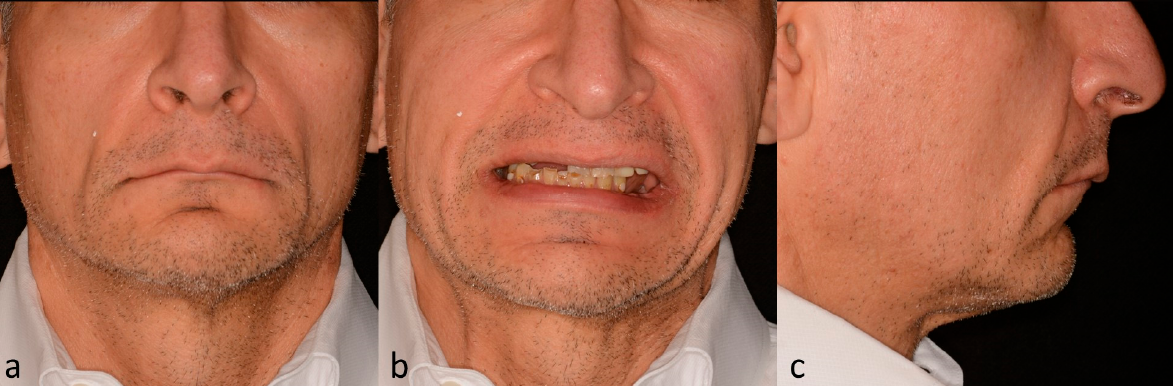
Figure 1. Initial situation. ( a ) Closed mouth, ( b ) Smile frontal view. ( c ) Lateral view with a closed mouth. The intraoral examination revealed partially edentulous maxillary and mandibular arches with an excessive vertical overlap and severe vertical and horizontal residual ridge deficiencies (Figure 2a). Multiple root tips, extensive wear facets, and restorations with secondary decay were observed in the remaining dentition (Figure 2b,c). The initial